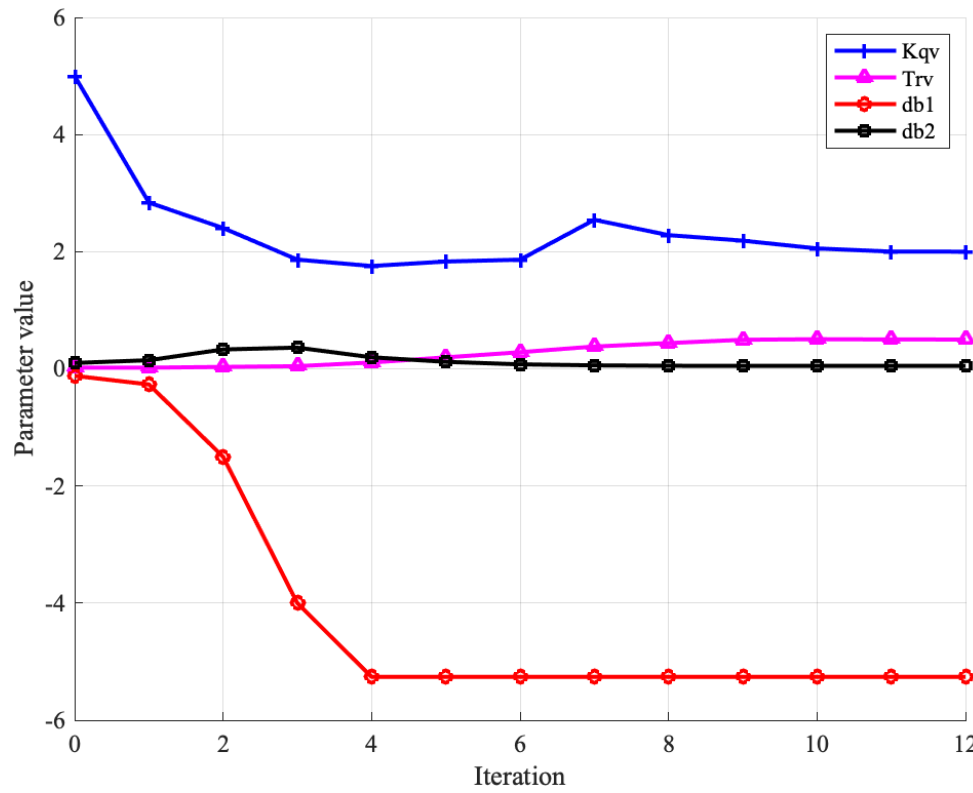
Figure 8. Progress of the parameters estimation process.